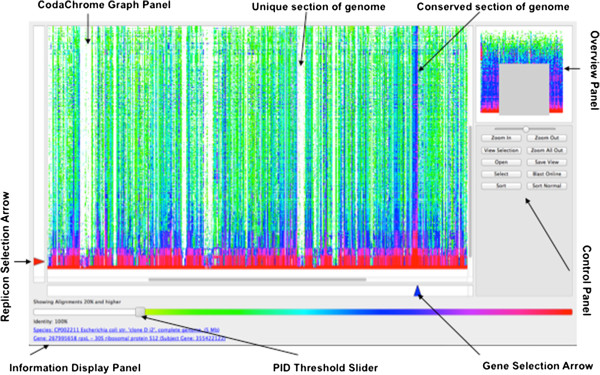
The CodaChrome GUI.Salmonella enterica 14028S was loaded as the seed organism. The rows were sorted by average proteome identity. The portion of the heat map visualized in the CodaChrome Graph Panel is indicated by the grey box in the Overview Panel. Lighter-than-normal vertical stripes represent large clusters of proteins unique to the seed organism. Dark vertical stripes represent clusters of highly conserved proteins. Buttons embedded in the control panel allow the user to interact with the visualization of the matrix file. A slider at the top of the control panel allows the user to zoom in or out. Replicon arrows and gene selection arrows indicate the alignment selected and described in the information display panel. Finally, the percent identity threshold slider allows users to filter alignments below a specified threshold. For this image, the threshold was set to 20%. The slider also functions as a legend indicating how percent identities are translated into color.